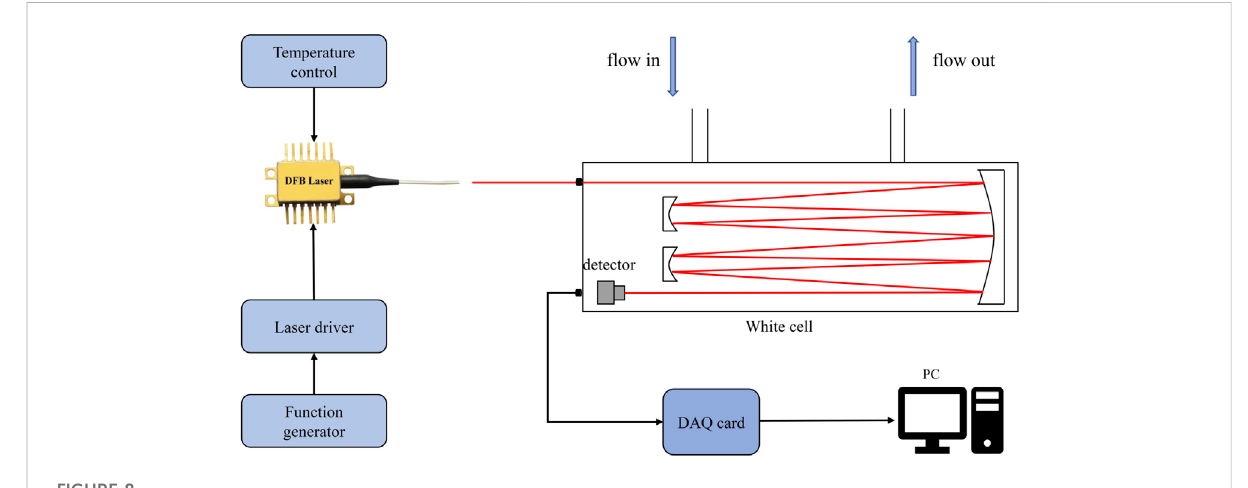
FIGURE 8 TDLAS experimental system